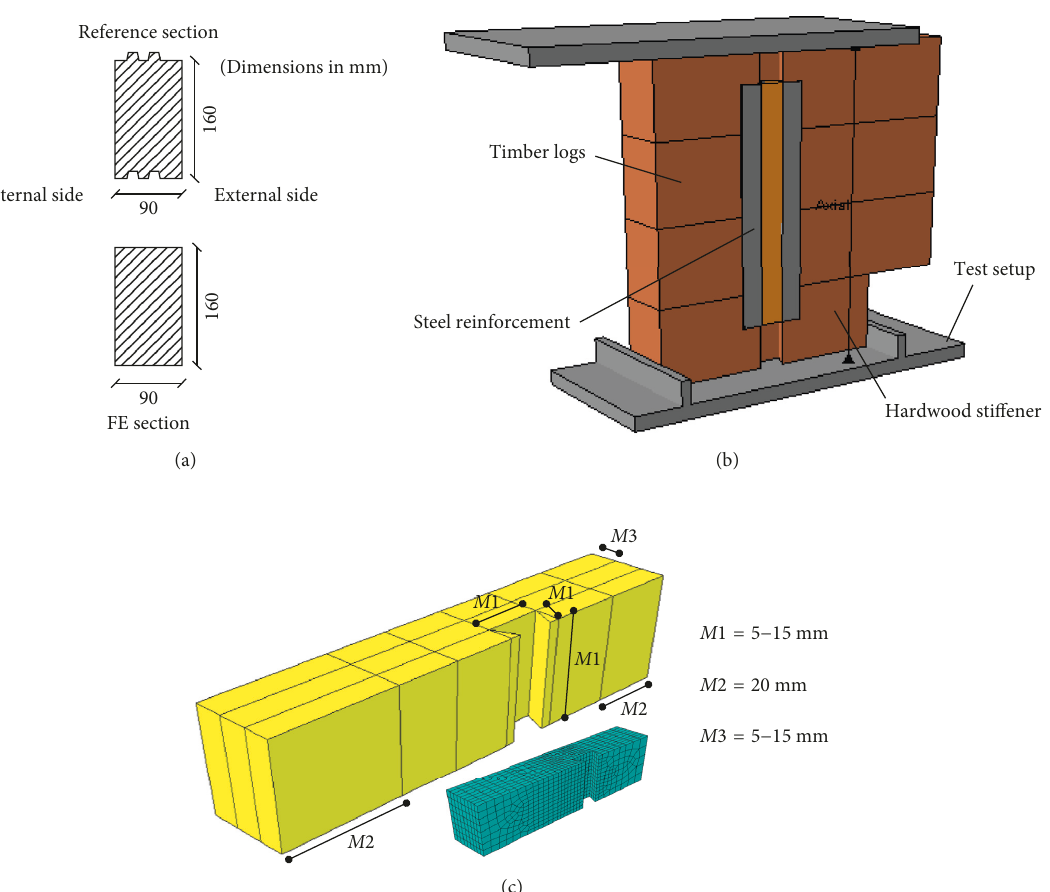
Figure 4: FE modelling of S01 and S02 specimens, with (a) cross-sectional features of logs; (b) full assembly (example proposed for the M02 model, with mesh pattern hidden from view); (c) mesh layout